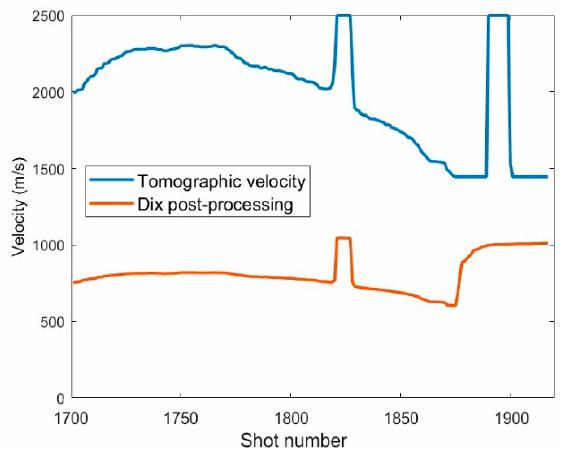
Figure 9. Estimated velocities with a 7-term median filtering for the shallow layer, within the area highlighted in Figure 7: tomographic inversion in the angle domain (blue line) and with the Dix post-processing (orange line).